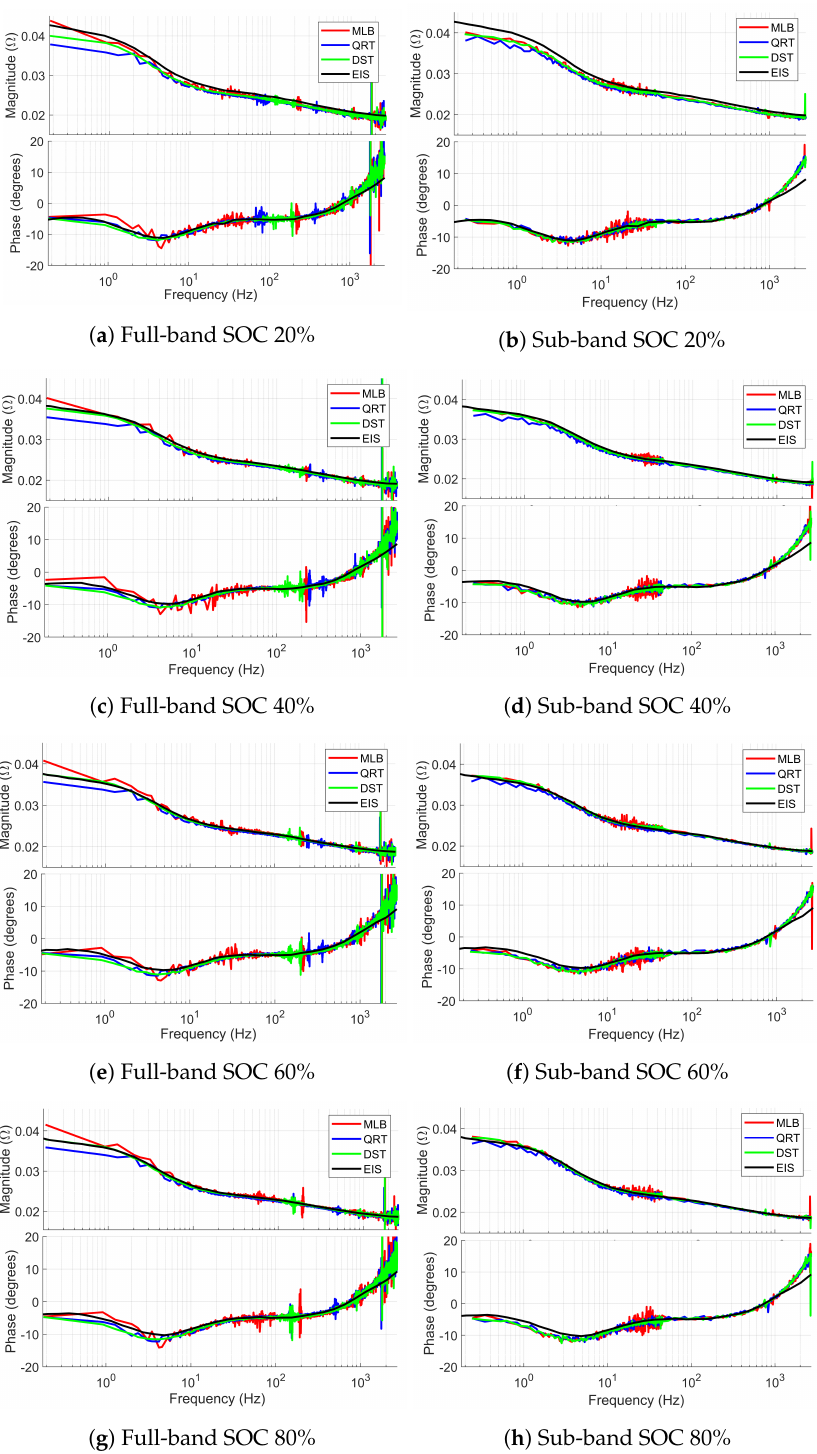
Figure 6. Bode plots of the full-band and sub-band impedance measurements at different SOCs. The NRMSE values from the PRS measurement are presented in Table 2. The NRMSE values are the smallest for the DST measurements, which indicate the increased performance of the method compared to other PRSs. Moreover, the performance of all PRS sequences are increased when using sub-band measurements. The values at 20% of SOC are higher than for other SOCs, which is due to the fact that the measurement conditions are not linear anymore either for the PRSs or the